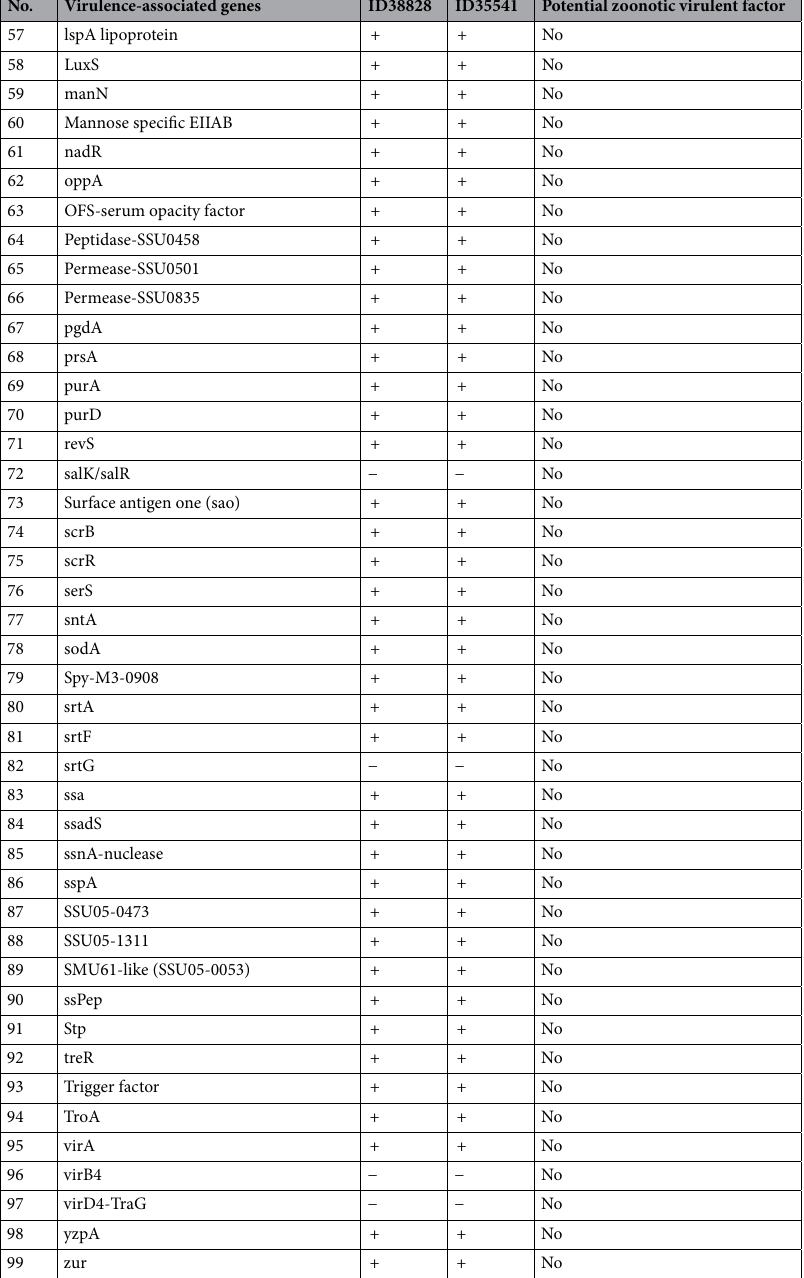
Table 1. Distribution of 99 virulence-associated genes in Streptococcus suis serotype 1. # Was a large variant epf (epf*). $ Was a small variant mrp s